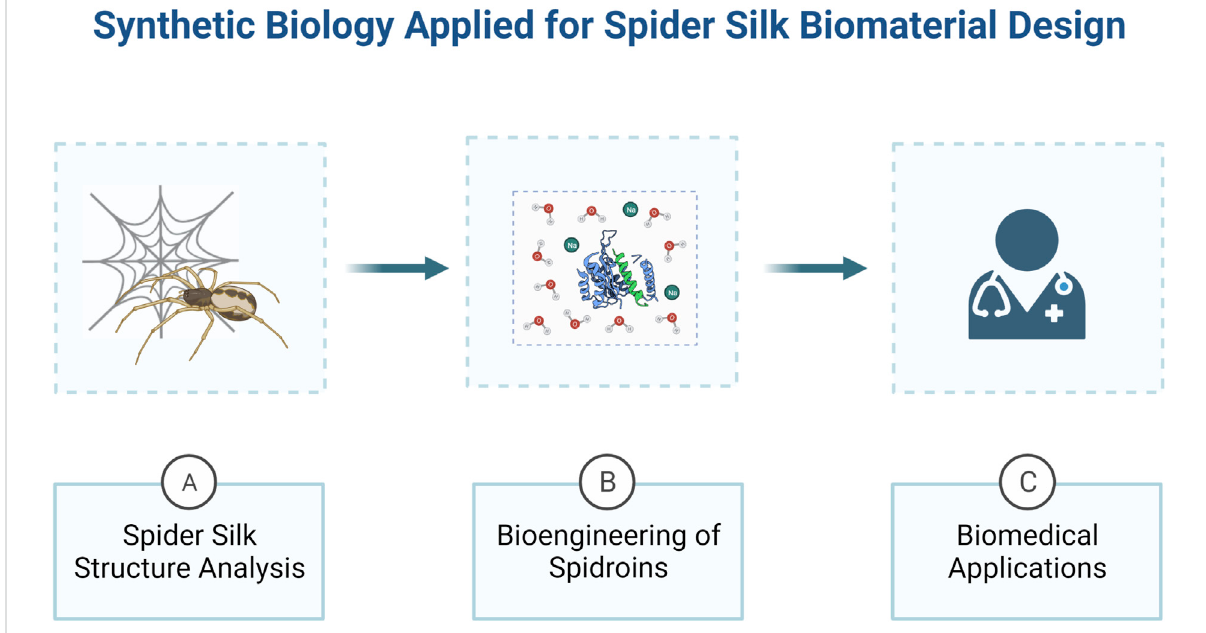
FIGURE 1 An overview of how synthetic biology can be applied for the development of spider silk bio-derived structural materials. Synthetic biology approaches are ideal to study spider silk proteins structure and mechanical properties (A) and engineering them to produce biomaterials with desirable properties (B) , in order to develop innovative biomedical devices (C) . Created with